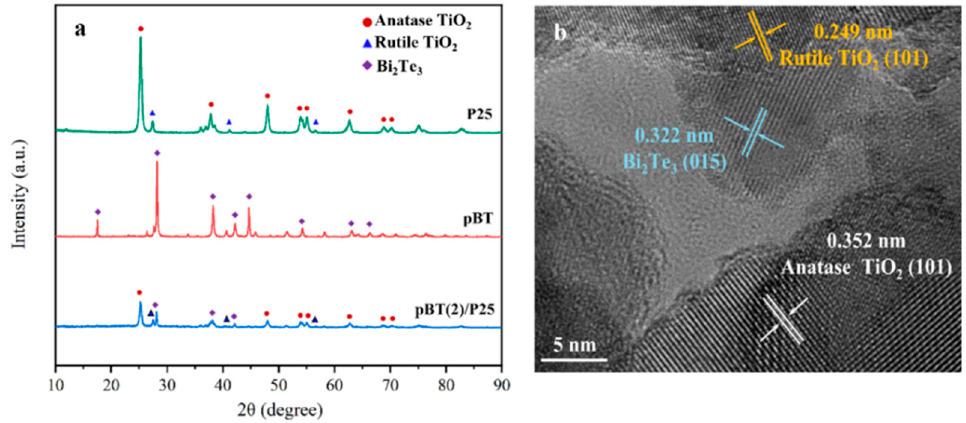
Figure 1. ( a ) XRD patterns of P25, pBT, and pBT(2)/P25; ( b ) HRTEM image of pBT(2)/P25.